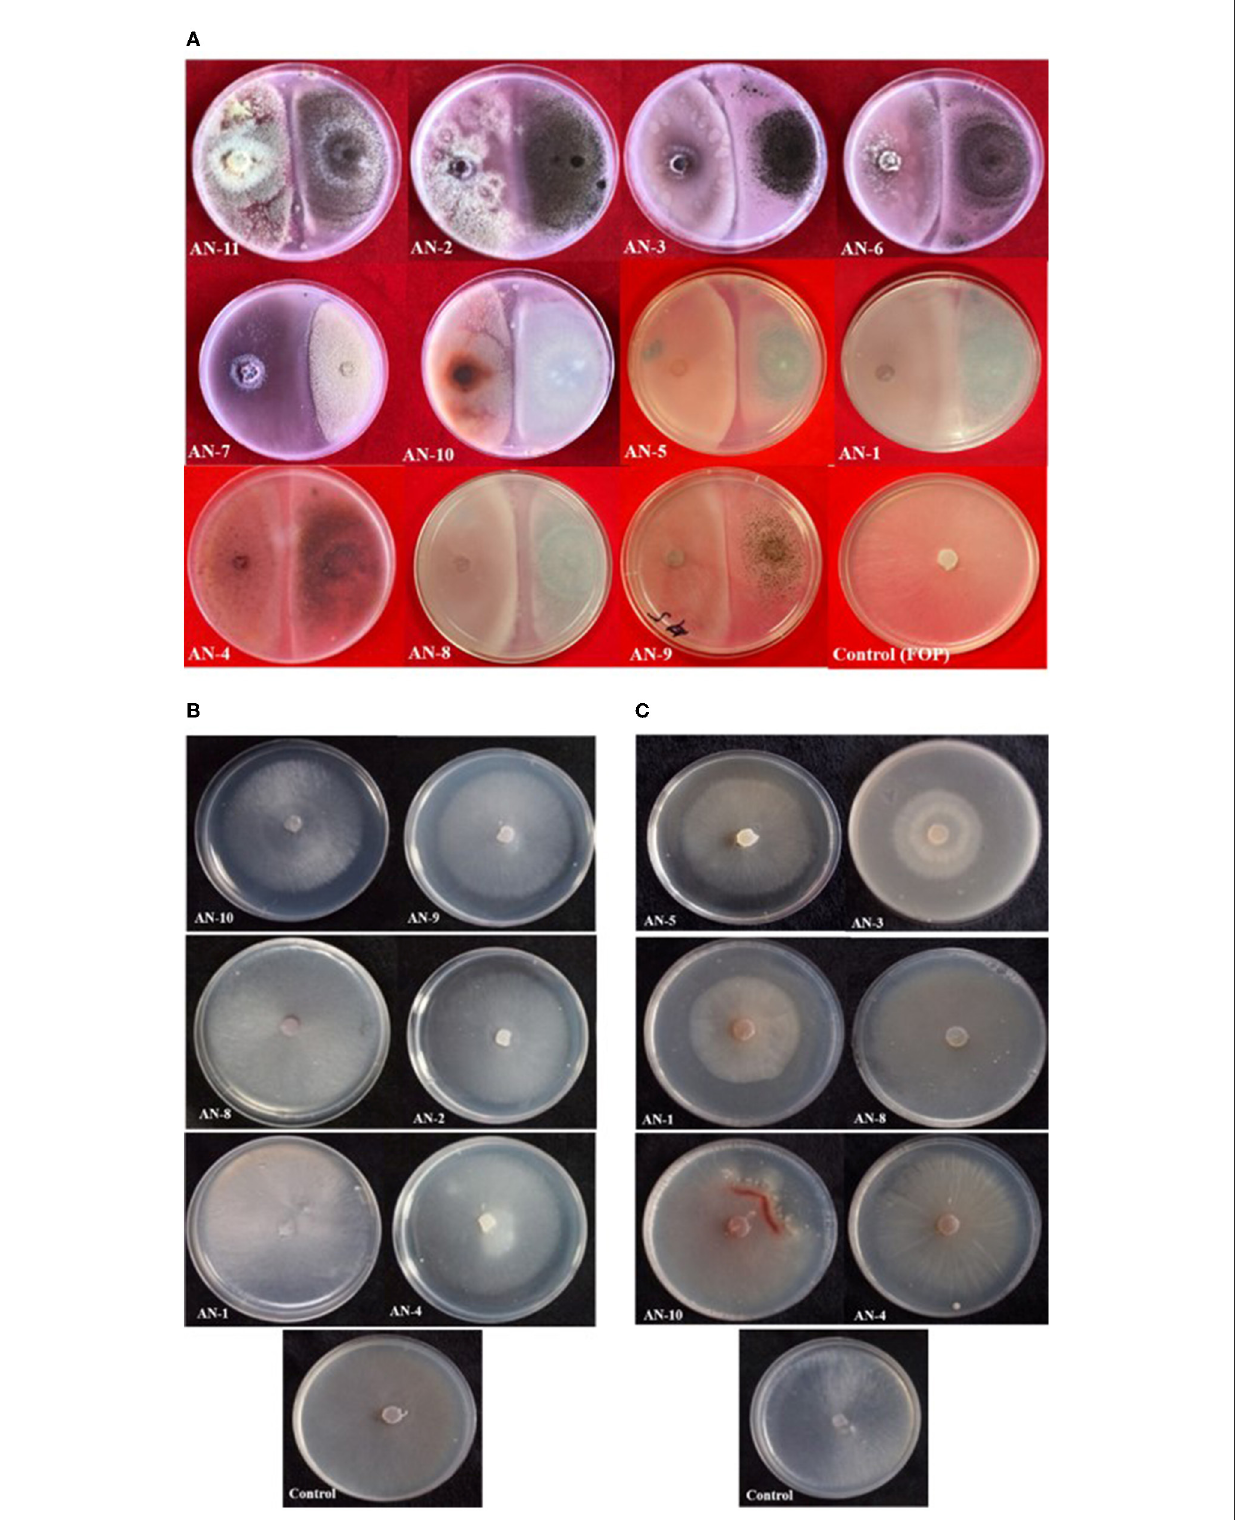
FIGURE3 Growth inhibition of F. oxysporum f. sp. psidii by A. niger strains under in vitro conditions after 7 days of incubation on potato dextrose agar (PDA) media. (A) Dual culture method. (B) Volatile assay. (C) Non-volatile